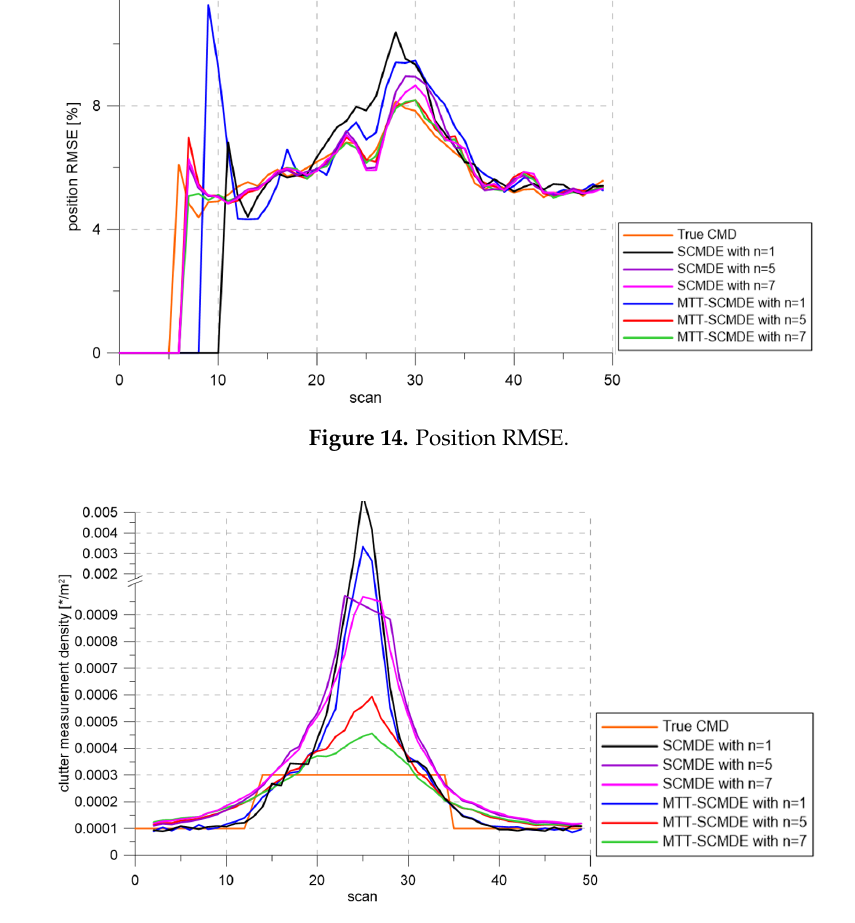
Figure 15. True clutter measurement density and estimated clutter measurement density. Table 3. Track retention statistics for Monte Carlo